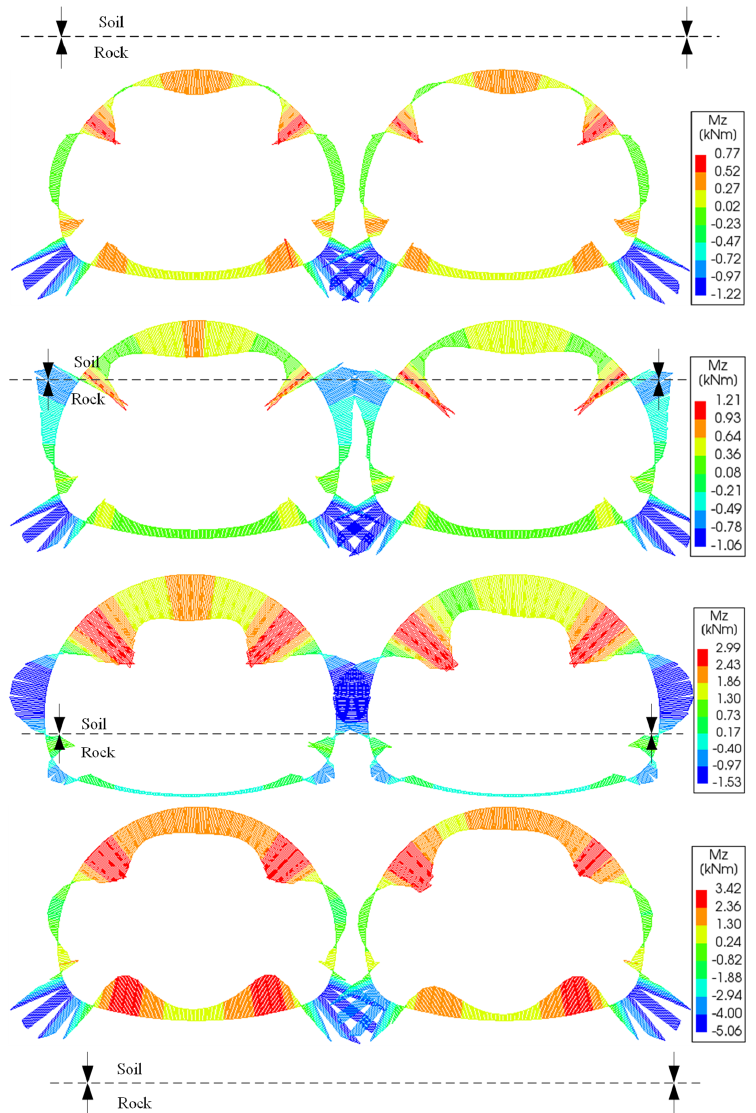
Figure 12. Bending moment of different soil-rock interface positions at a buried depth of 5 m.